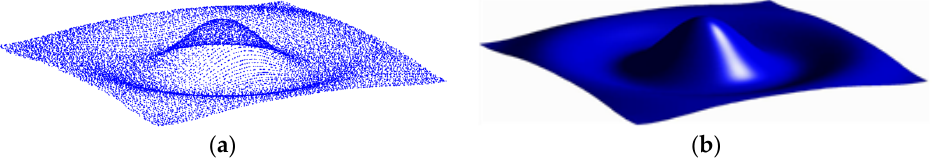
Figure 7. Surface fitting of a hat surface: ( a ) the scattered data chosen randomly from grid data; ( b ) the fitting surface.